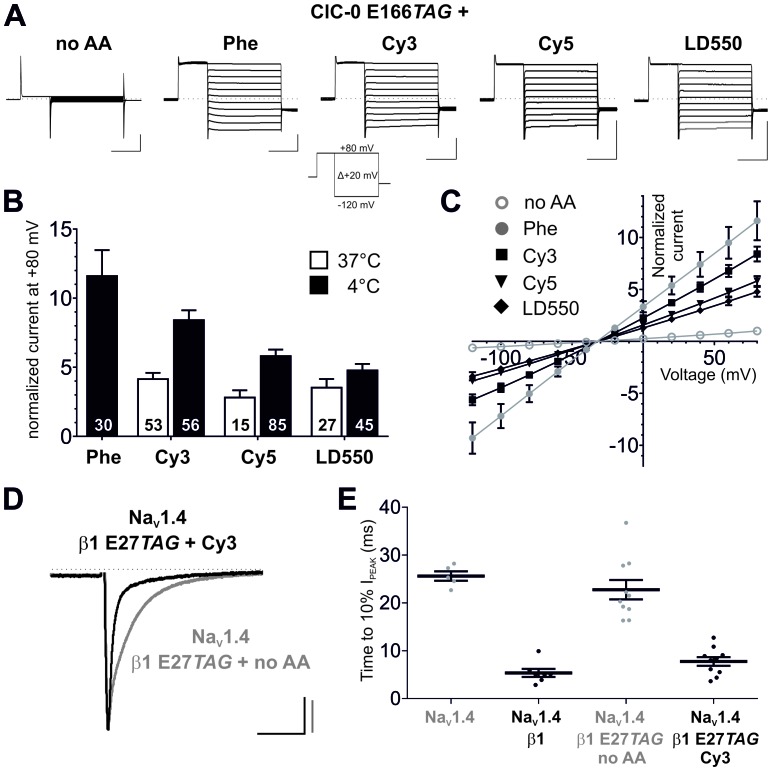
Genetic encoding of Cy-ncAAs into membrane proteins in Xenopus laevis oocytes.(A) to (C) Nonsense suppression of ClC-0 E166TAG. (A) The chloride channel function of ClC-0 was successfully reconstituted with the misacylated tRNAs (Phe, Cy3, Cy5, LD550) while nonacylated tRNA (no AA) yielded no functional channels. Representative TEVC current recordings and the voltage clamp protocol are shown. Horizontal scale bars indicate time (50 ms), vertical scale bars the current amplitude (10 µA). Note that traces were scaled to unity for clearer presentation of current properties. (B) For quantification, currents elicited by a +80 mV pulse in oocytes expressing reconstituted chloride channels were normalized to currents of the background control (no AA). Black bars indicate rescue by suppressor tRNA acylated at 4°C for 2 hr, white bars show results for tRNA acylated at 37°C for 40 min. For Cy3 and Cy5, rescue of ClC-0 E166TAG has been significantly increased by using tRNAs acylated at 4°C (Cy3: p<0.001; Cy5: p=0.01; LD550: p=0.11). Values for the fold increase in conductance are shown as mean ± s.e.m.; numbers of individual oocytes tested are indicated (for 4°C results were pooled from 5–11 different batches of oocytes; for 37°C from 2–7 batches). (C) Steady-state current-voltage relationships for all conditions shown in (A) and recordings quantified in (B) for 4°C. As predicted, the reconstituted channels behave as voltage-independent, constitutively open conductances with a reversal potential around the chloride equilibrium potential, indicative of a chloride-selective channel. (D) and (E) Nonsense suppression of NaVβ1 E27TAG. (D) Representative TEVC recordings of oocytes coinjected with NaV1.4 and β1 E27TAG + Cy3-tRNA (black) or β1 E27TAG + nonacylated tRNA (grey). Accelerated NaV1.4 fast-inactivation kinetics (black) indicate successful incorporation of Cy3 into β1. Currents were elicited by a 50 ms test pulse to −20 mV from a holding potential of −120 mV. They were scaled to unity for illustration purposes; scale bars: horizontal indicates time (20 ms), vertical indicates current amplitude (1 µA). (E) For quantification of the effect on inactivation kinetics the time period till the peak current (IPEAK) decayed to 10% of its initial value was estimated. Results for NaV1.4 + β1 E27TAG + no AA (23 ± 2.1 ms) were not significantly different from NaV1.4 expressed alone (26 ± 1.1 ms; p=0.36). Both, wild-type β1 and the reconstituted β1, significantly accelerated the inactivation kinetics of NaV1.4 to 5 ± 0.9 ms and 8 ± 1.0 ms, respectively, while not being significantly different from each other (p=0.08). Analysis includes data from two oocyte batches. Values are presented as mean ± s.e.m.